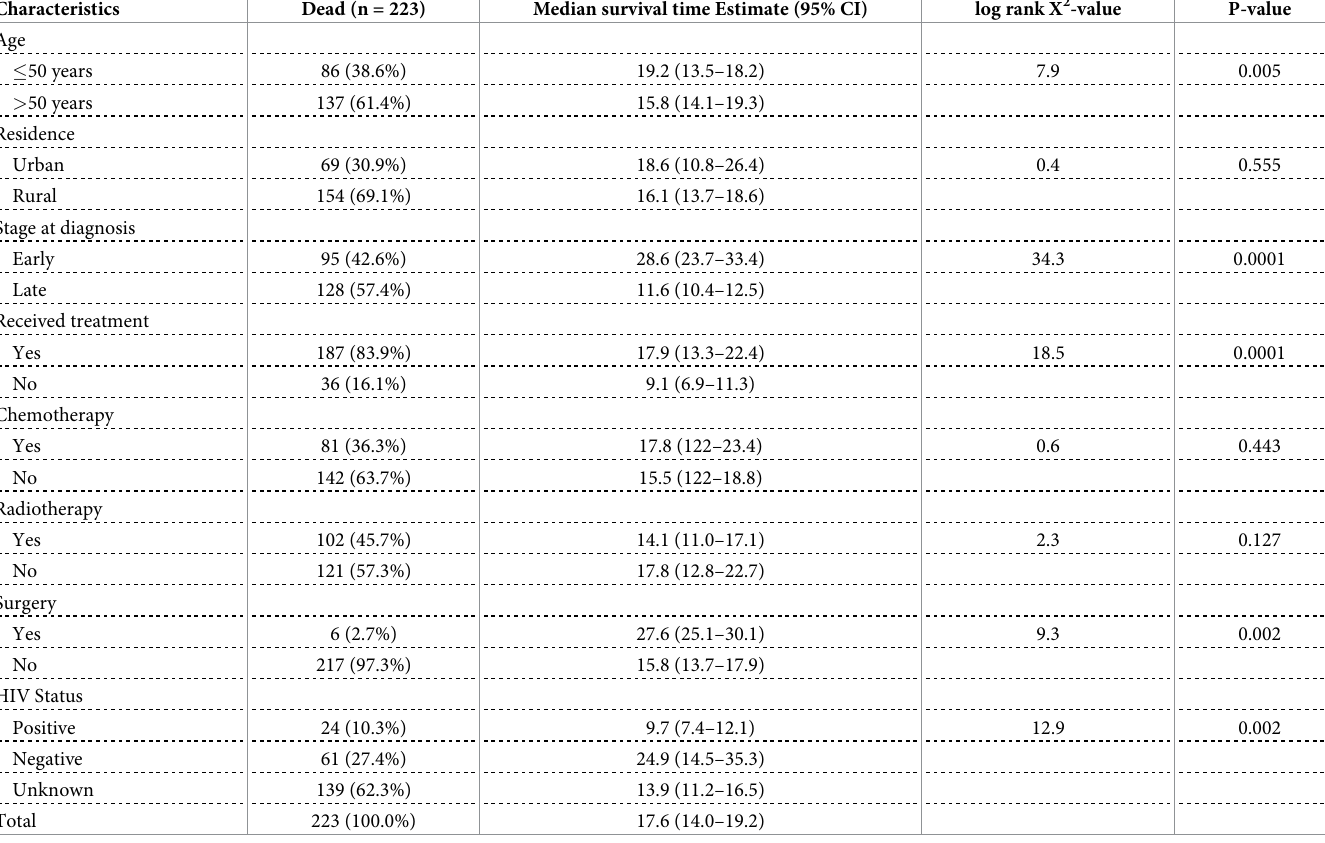
Table 4. Survival time among different groups of CCP in TASH, June 2014 to June 2019.